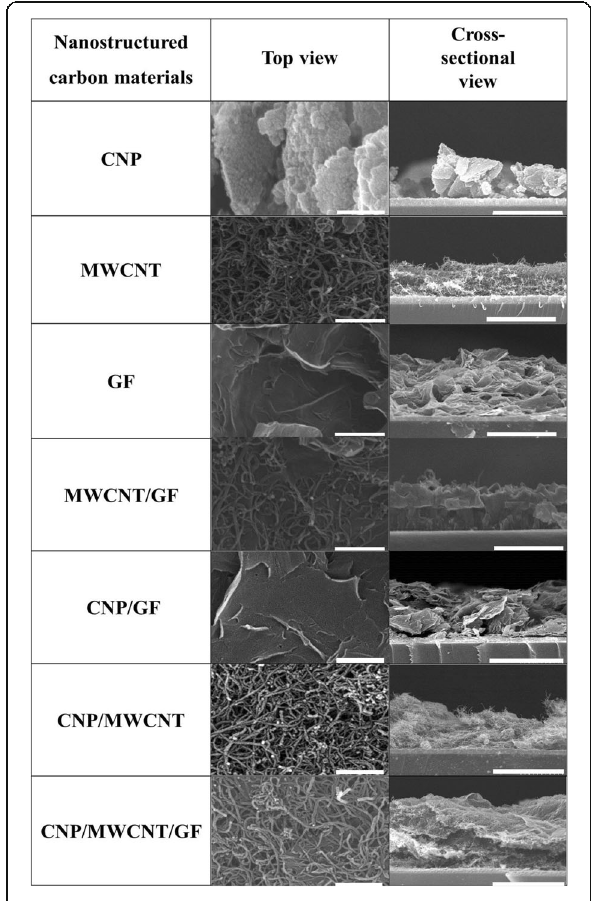
Fig. 4 Top- and cross-sectional views of various carbon materials, including CNP, MWCNT, GF, MWCNT/GF, CNP/GF, CNP/MWCNT, CNP/MWCNT/GF stacked on the surface of FTO glass using screen- printing process (the scale bars in the top view images are 0.5 μ m, and the scale bars in the cross-sectional view images are 5 μ